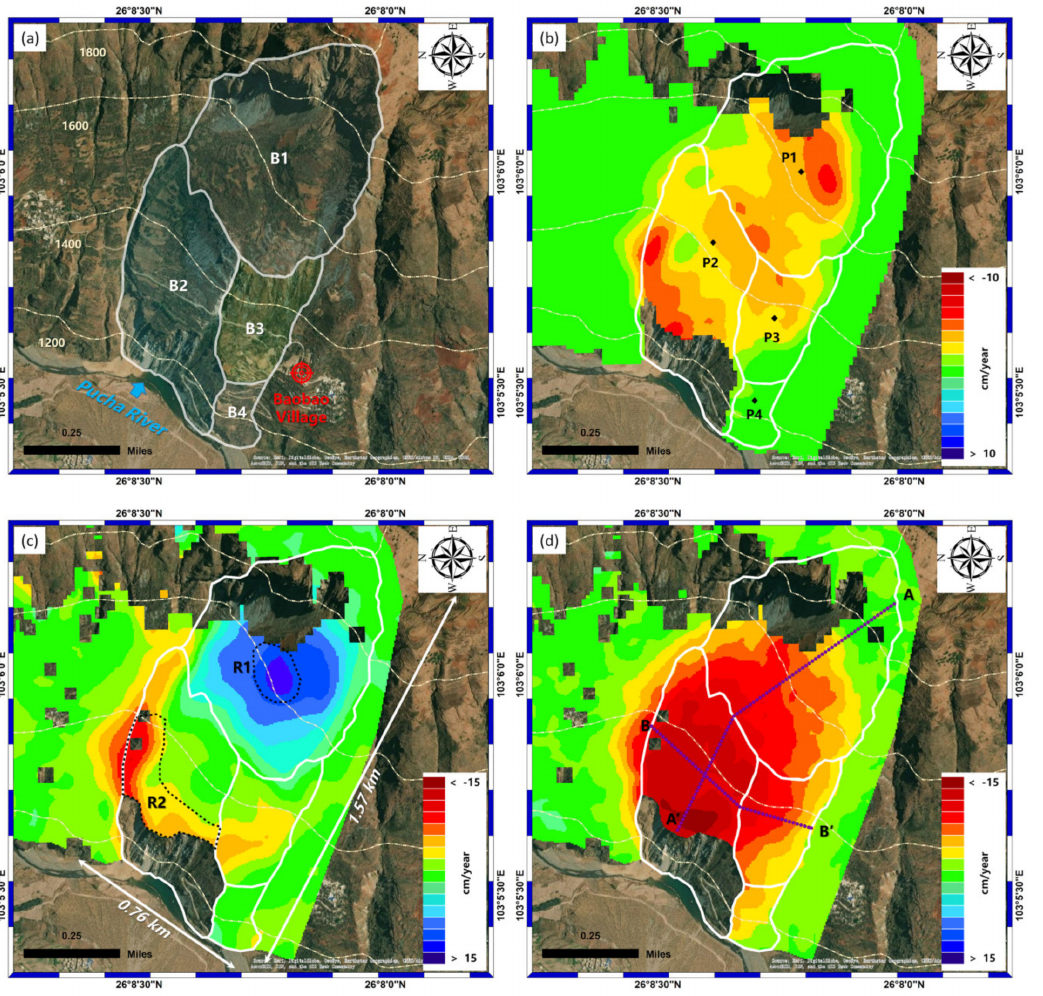
Figure 7. Optimal remote sensing image and three-dimensional displacement rate maps during March 2017 to May 2019 of the Baobao landslide. ( a ) Optical image acquired in April 2019. White curves map the boundary of the landslide movement and different colors represent four Blocks B1–B4. ( b ) Vertical displacement rate map, where Points P1–P4 are selected to analysis their time series of displacement in optimal sliding direction. ( c ) North-south displacement rate map, where black dotted curves mapped two most active sliding regions (R1 and R2). ( d ) East-west displacement rate map, where two lines indicate the locations of Profiles AA’ and BB’. Moreover, yellow dotted lines are topographic contour